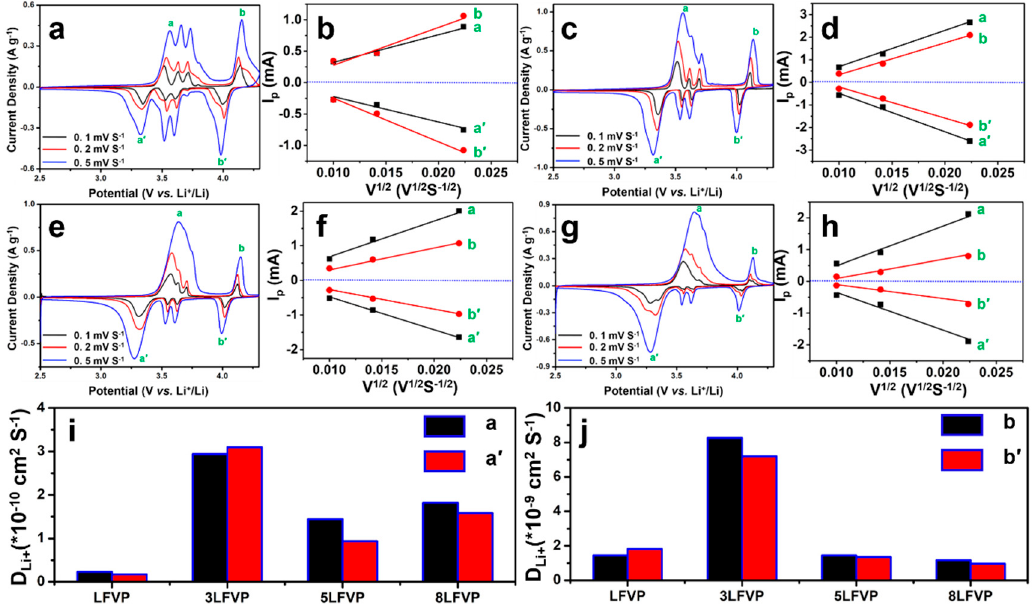
Figure 2. ( a , c , e , g ) CV curves of LFVP, 3LFVP, 5LFVP, and 8LFVP, respectively; ( b , d , f , h ) relationship between I p and V 1/2 in LFVP, 3LFVP, 5LFVP, and 8LFVP electrodes, respectively; ( i , j ) Li-ion diffusion coefficients of LFP and LVP (labeled as a/a ′ and b/b ′ ) in series of xLFP·yLVP electrodes.